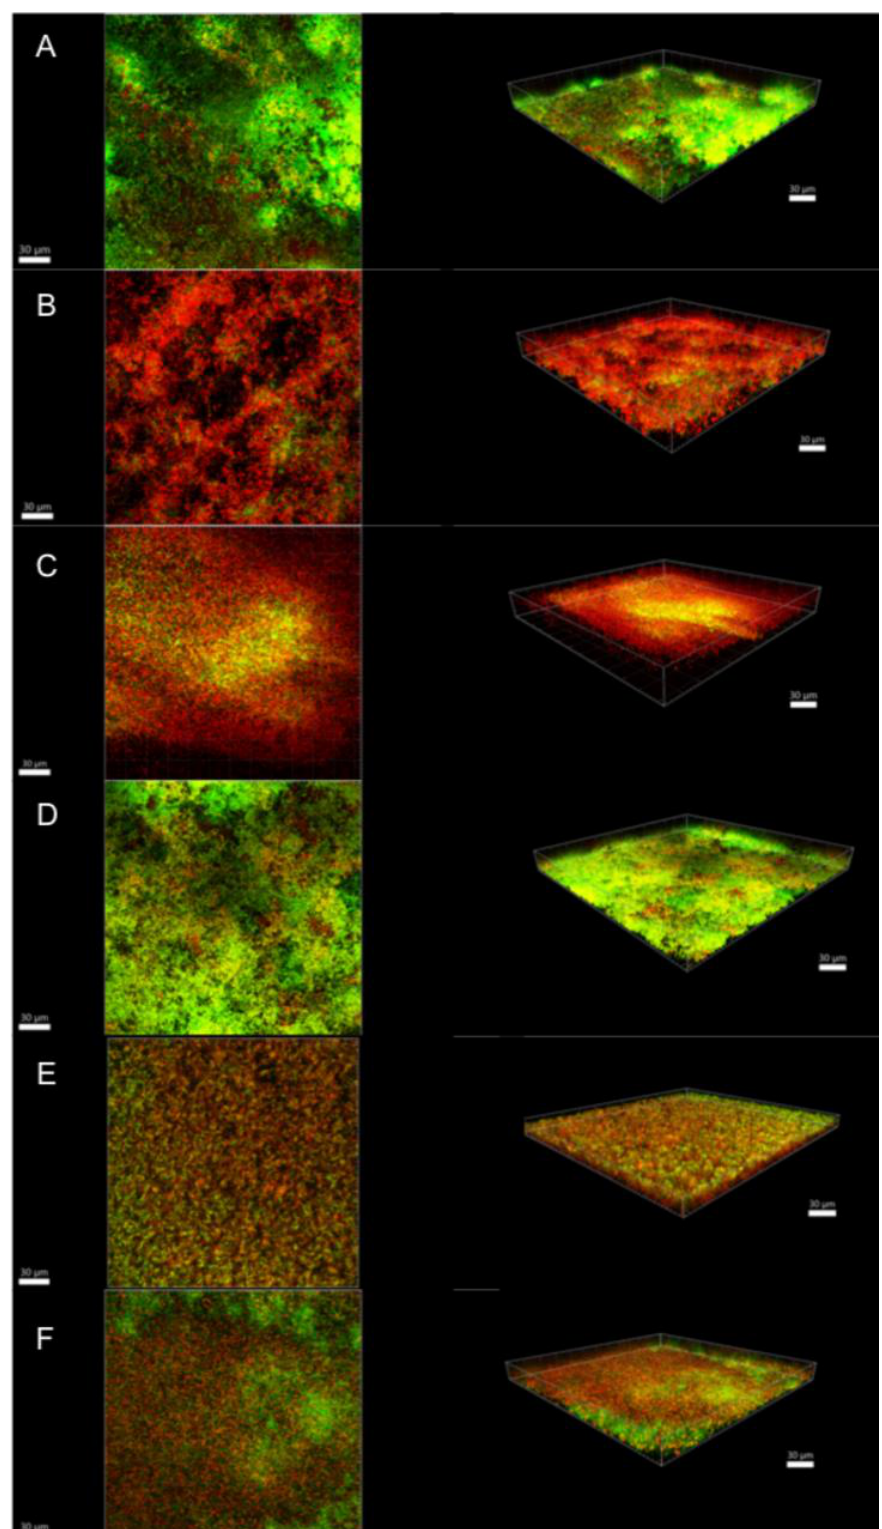
Figure 3. Confocal laser scanning microscopy images of 15-day biofilms. ( A ) Saline; ( B ) 1.5% NaOCl; ( C ) 17% EDTA; ( D ) high-purity nisin; ( E ) 1.5% NaOCl + high-purity nisin; and ( F ) 17% EDTA + high-purity nisin. The biofilms were stained using the LIVE/DEAD Viability Kit; live cells appear green and dead cells red. Images represent the 3D reconstructions of the biofilms using IMARIS 7.6.5 software (orthogonal and perspective views from left to right). Scale bar 30 μm.